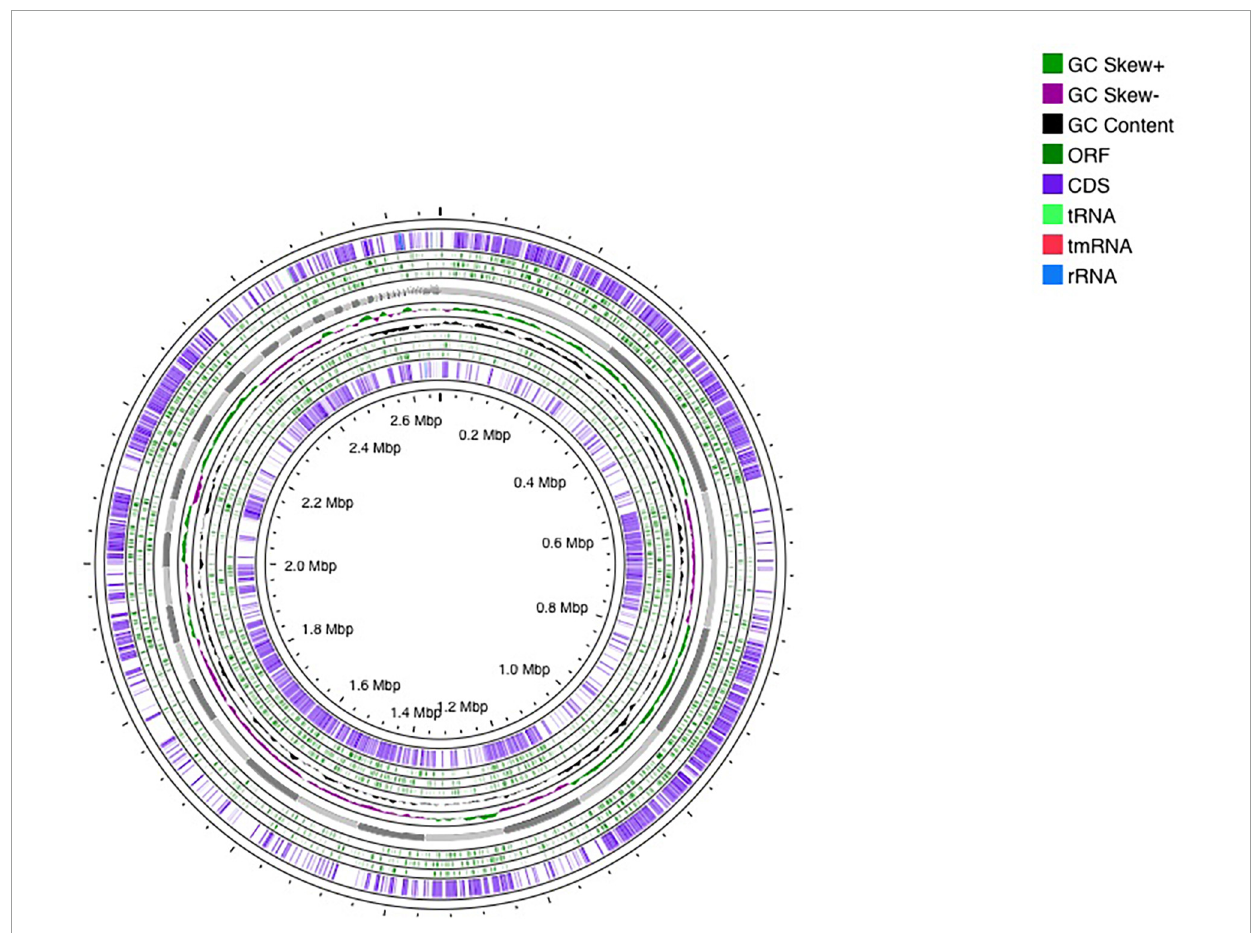
FIGURE1 Circular representation of Enterococcus faecium LR13 draft genome. The circles were generated using a CG view server.